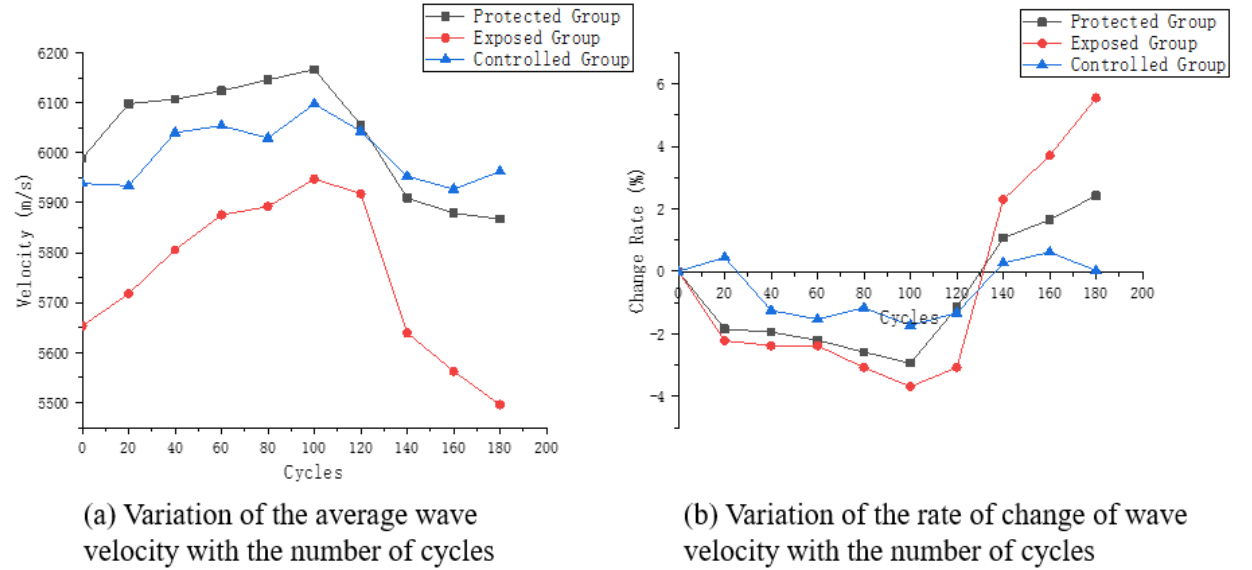
Figure 4. Ultrasonic velocity characteristic curve.